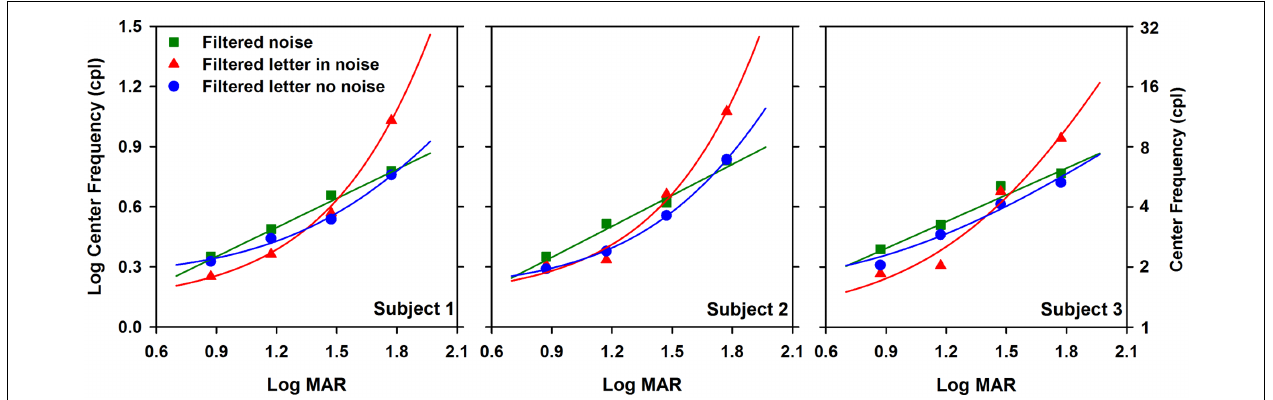
FIGURE 3 | Log center frequency (cpl) as a function of letter size (log MAR). Data are shown for each subject separately. Exponential curves were fit to the filtered letter in noise (triangles) and filtered letter in no noise (circles) data and a linear function was fit to the unfiltered letter in filtered noise data (squares).